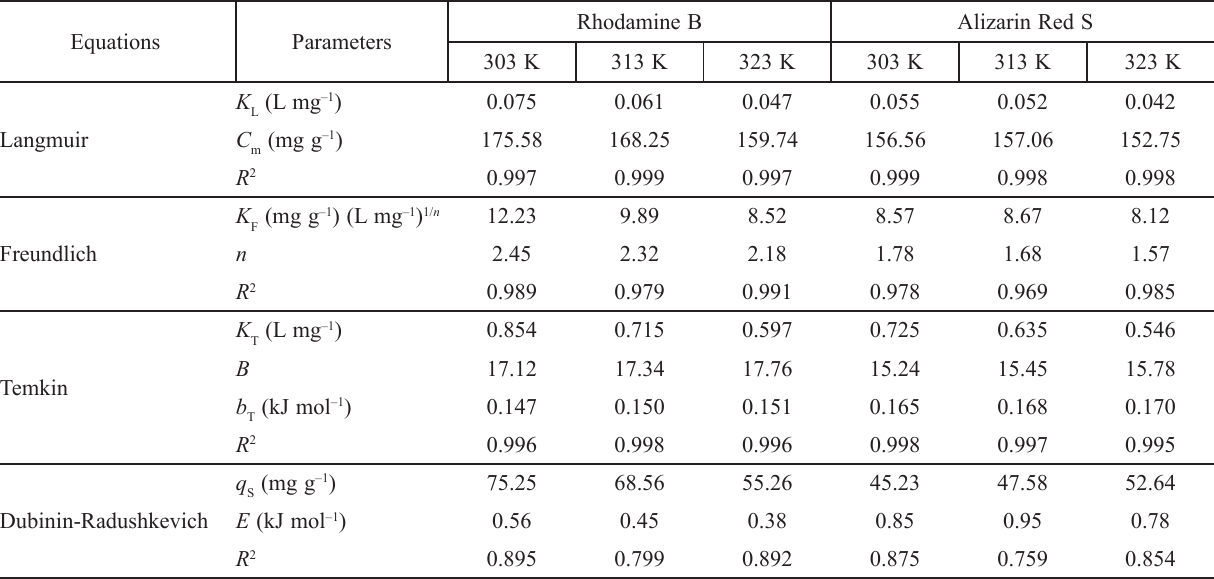
Table 5 – Isotherms data for the adsorption of Rhodamine B and Alizarin Red S dyes onto CES adsorbent at different temperatures